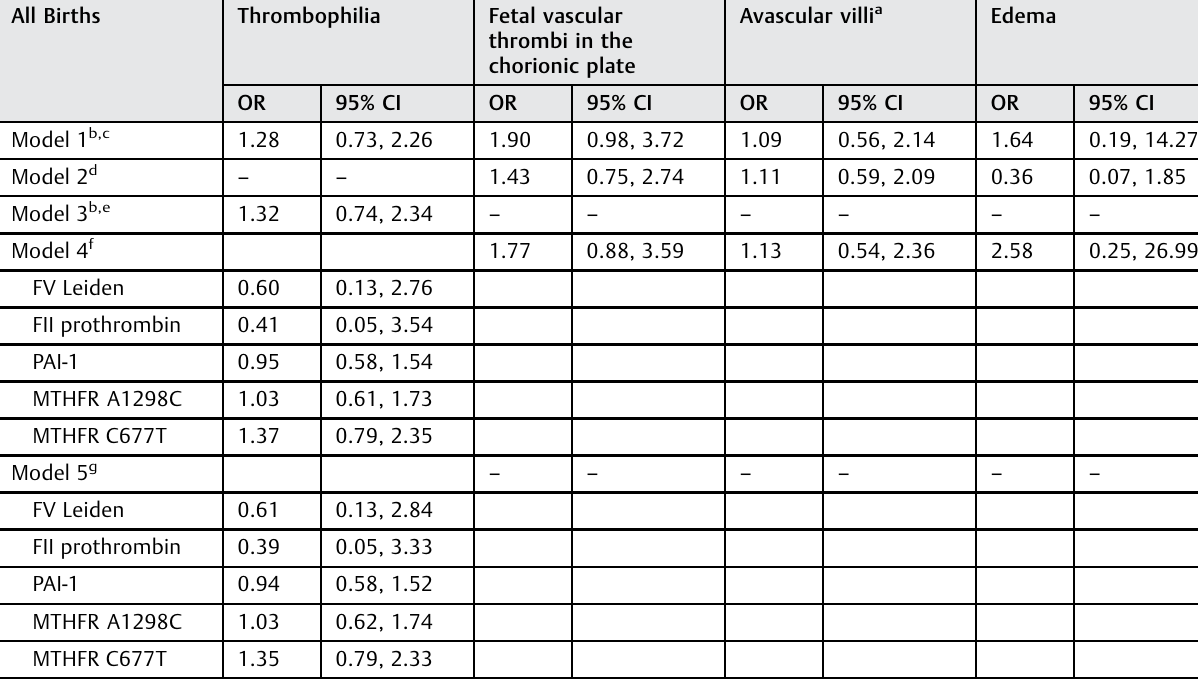
Table 8 Odds ratios for small for gestational age ( < 10th percentile) as a function of presence of thrombophilia markers in placenta/cord blood and placental characteristics related to fetal vascular malperfusion All